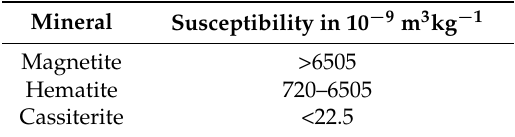
Table 2. Susceptibility ranges for some chosen minerals